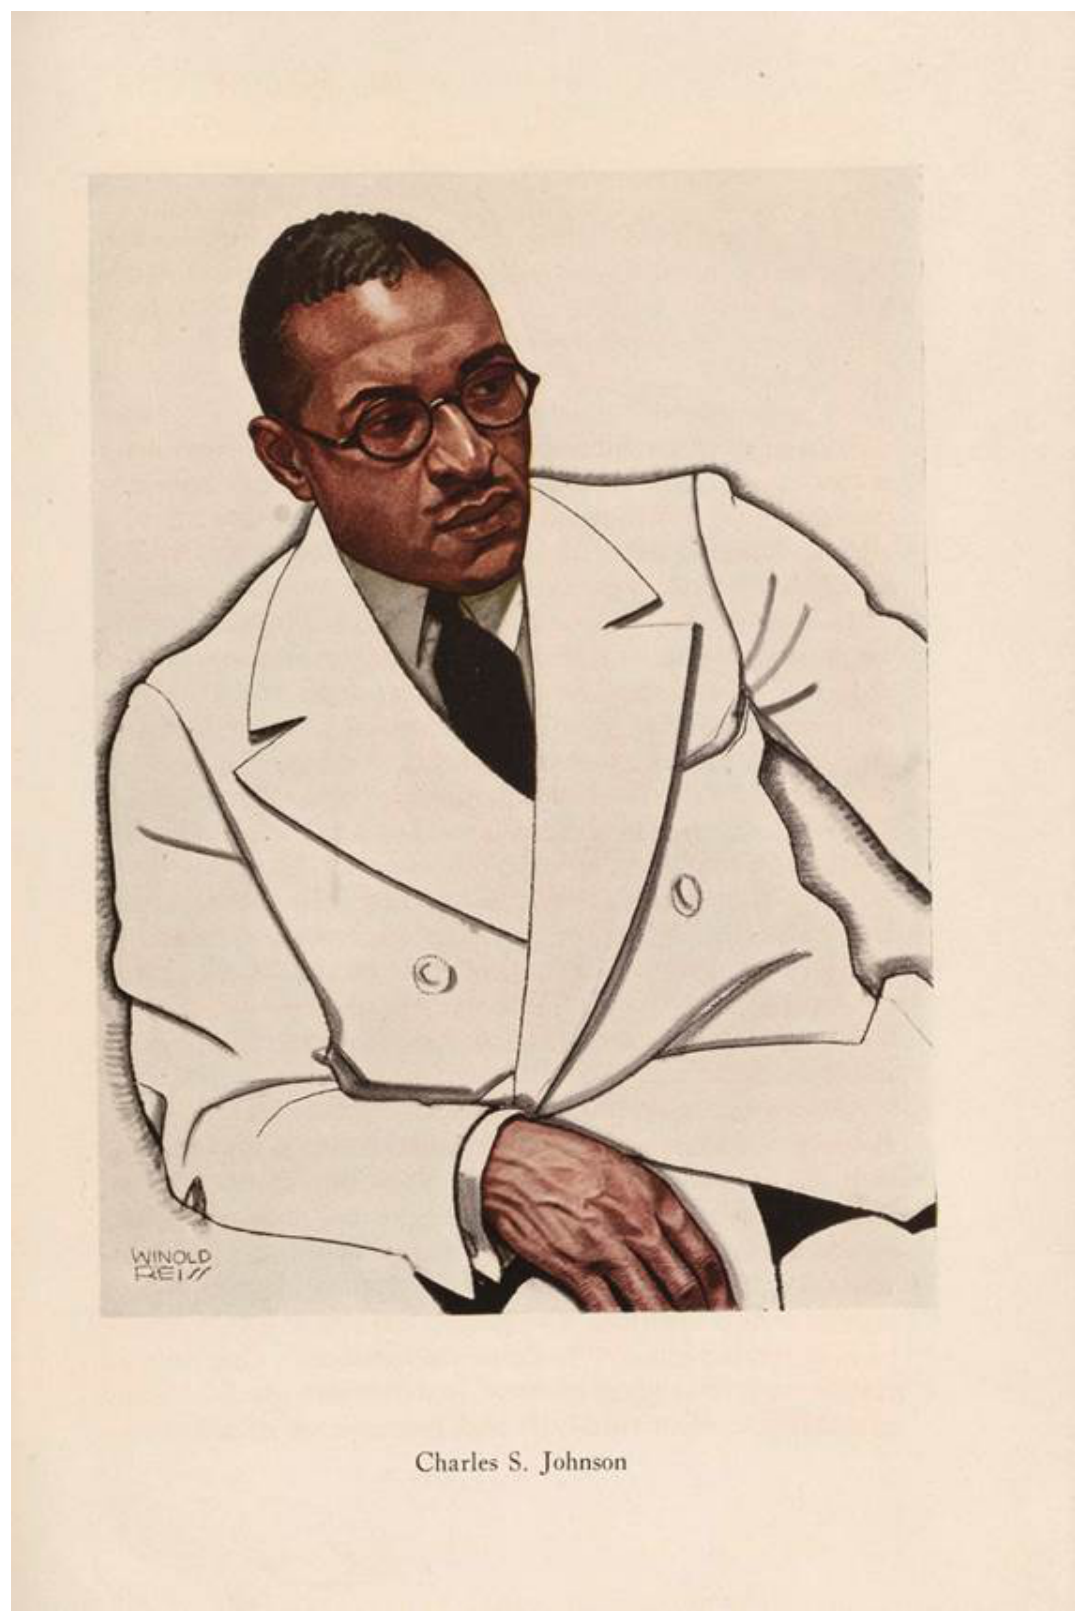
Figure 7 Winold Reiss, ‘Portrait: Charles S. Johnson’, The New Negro: An Interpretation (1925), facing page 278 (Courtesy: National Portrait Gallery, Smithsonian